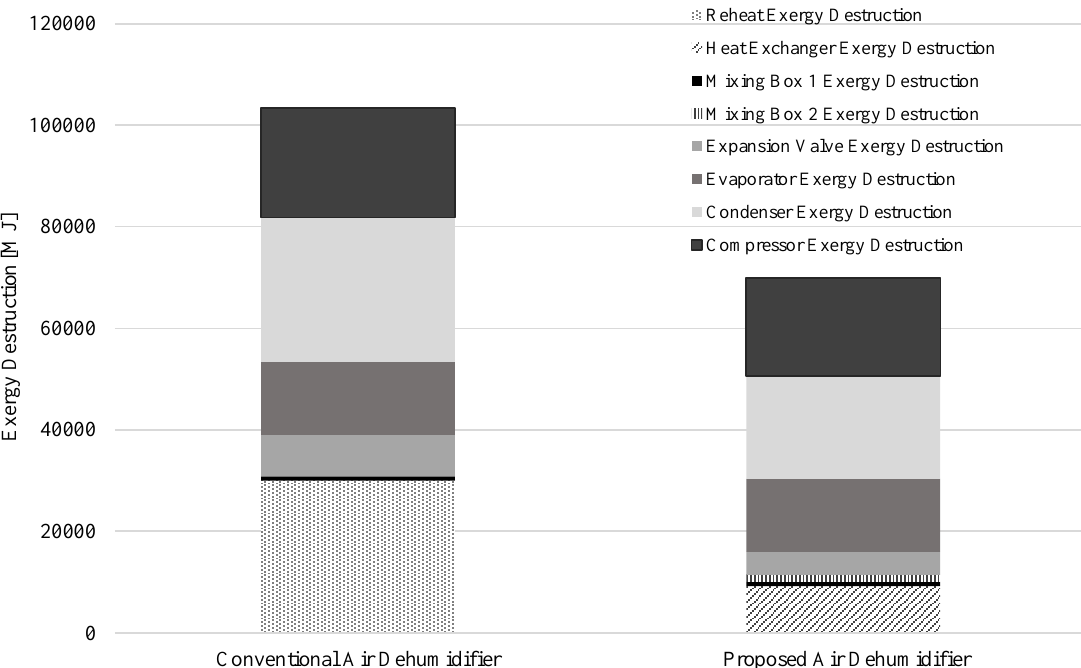
Figure 4. Net exergy destruction in both air